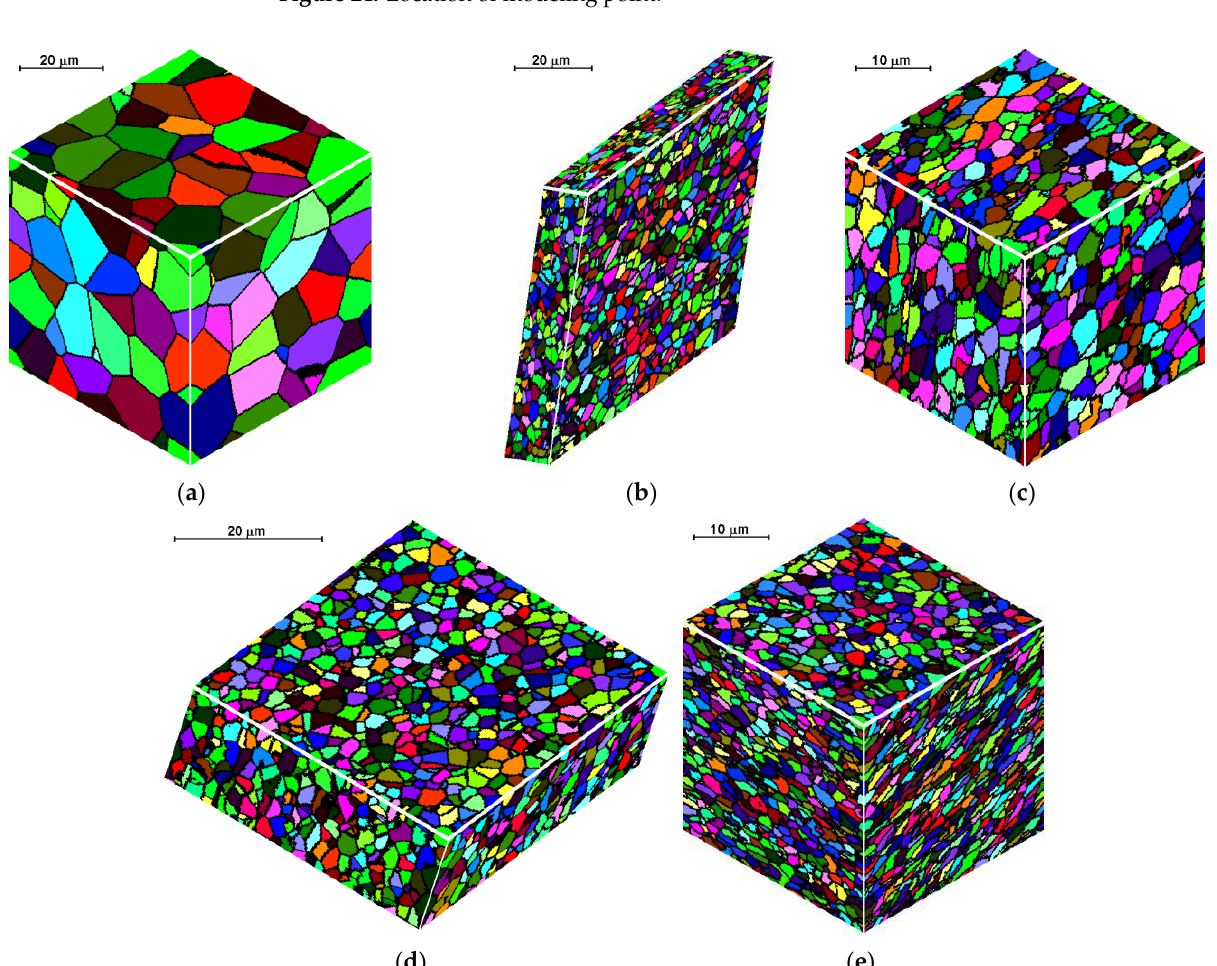
Figure 25. Microstructures: ( a ) initial, ( b ) before 2nd pass, ( c ) before 2nd pass and after straightening, ( d ) final microstructure, ( e ) final microstructure after straightening.